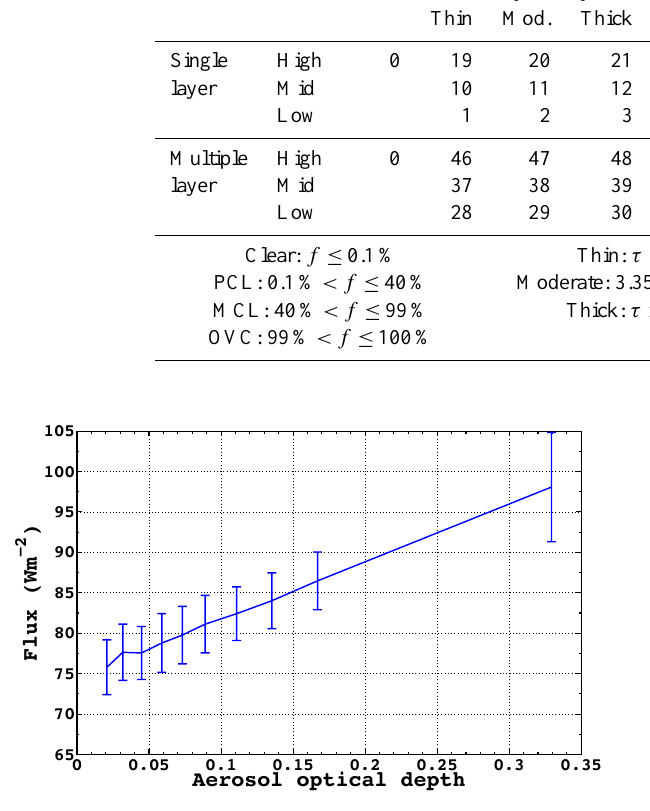
Figure 3. Mean oblique-view CERES fluxes and the relative RMSE (Eq. 6, in %) between oblique-view and near-nadir-view fluxes as a function of MODIS aerosol optical depth over clear ocean. The RMSEs are shown as error